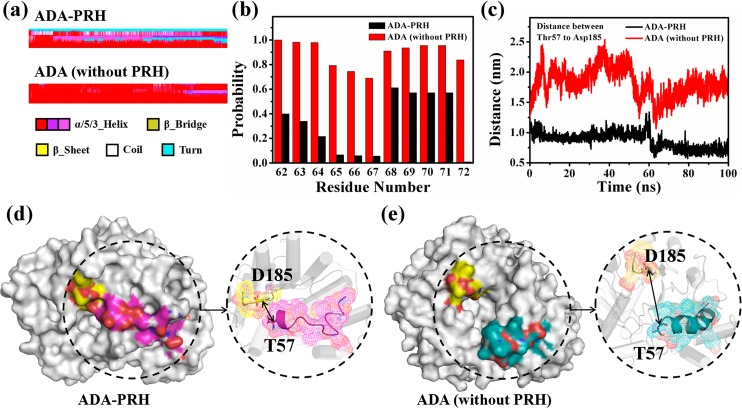
Conformation change in residues T57 to A73 of the two systems: ADA-PRH and ADA (without PRH).(a) Differences in the secondary structures (DSSPs) of T57 to A73 between the two systems. (b) Probabilities of L62 to I72 to form a helix. (c) Distance changes between Thr57 and Ile185 in the 100 ns simulations. (d) ADA-PRH complex (left) on the surface, residues T57 to A73, and residues A183 to I188 (right) in a mesh. (e) ADA (without PRH) (left) on the surface, residues T57 to A73, and residues A183 to I188 (right) in a mesh.